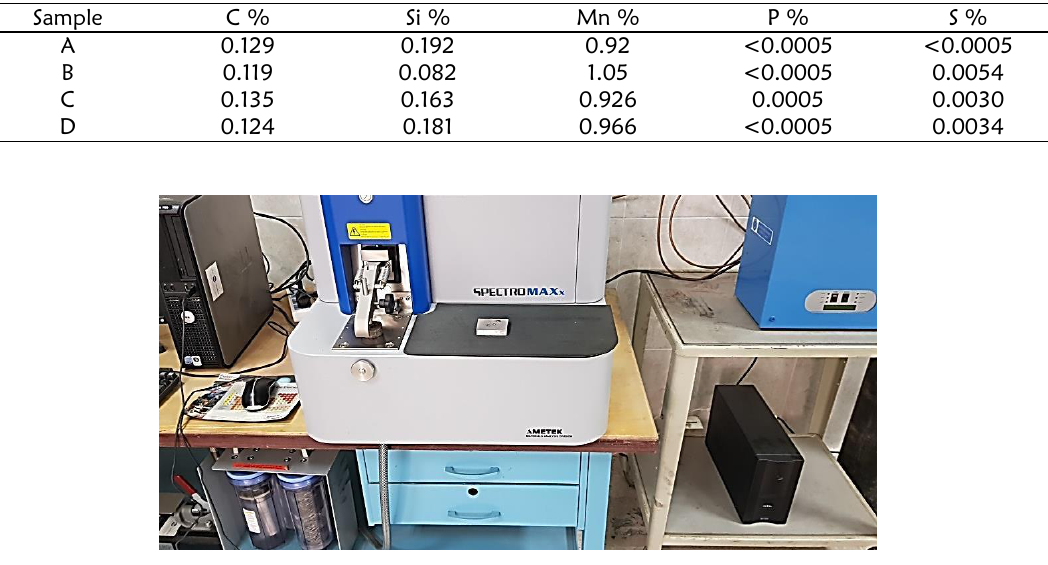
Table 3: Chemical composition of LPG cylinders and unformed plate